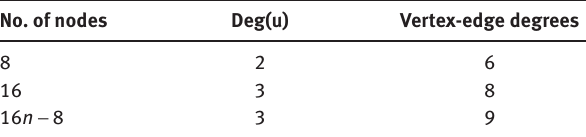
Table 2: Nodes partitioning of (